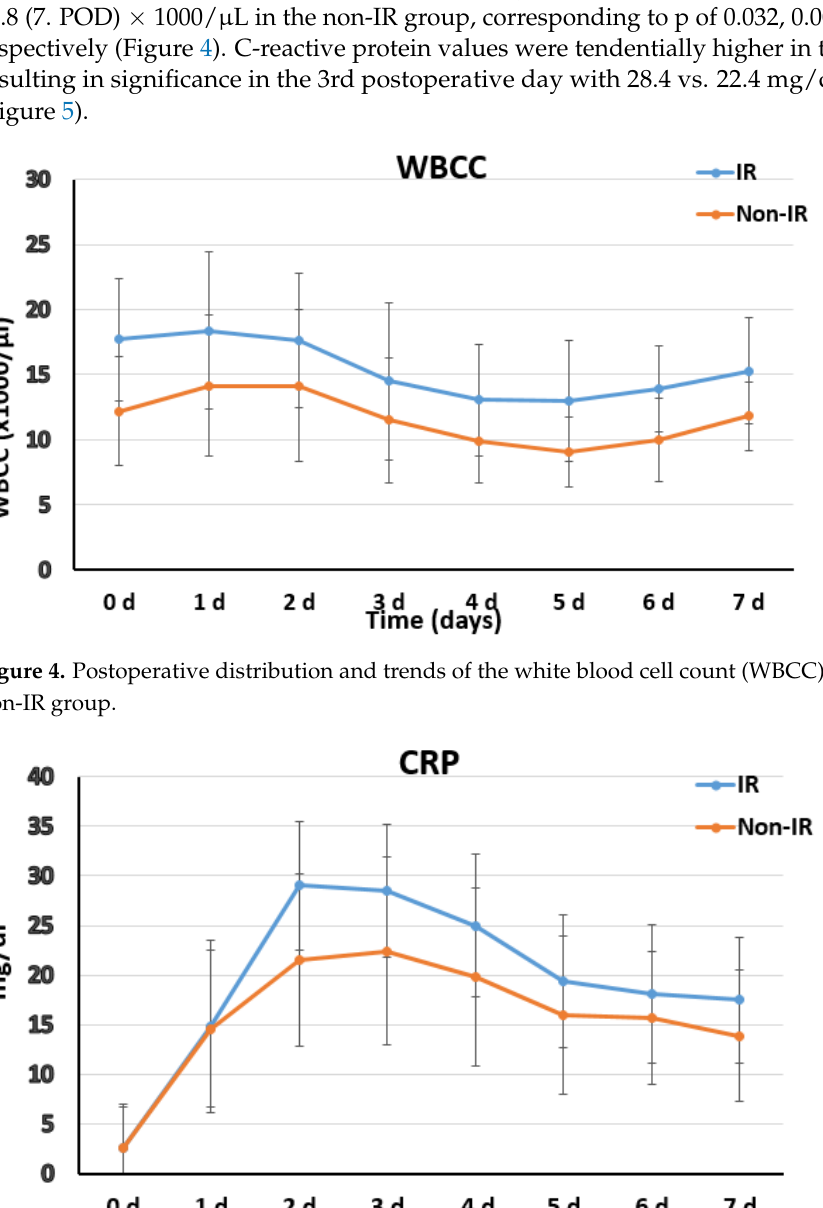
Table 4. Multivariate analysis of the significant variables associated with the occurrence of IR.